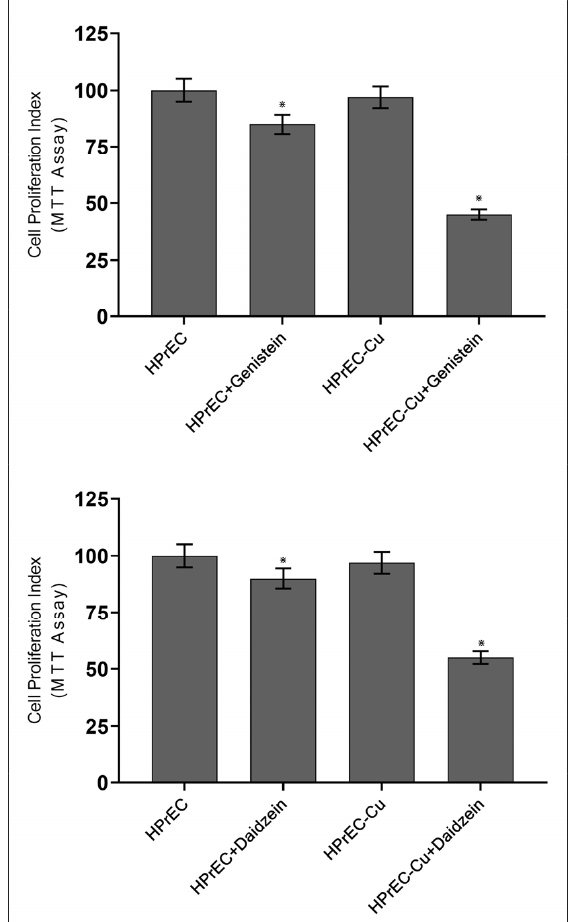
Figure 7. The effect of isoflavones on cell proliferation inhibition in normal prostate epithelial cells (HPrEC) and HPrEC cells cultured in copper-supplemented media (HPrEC-Cu). HPrEC and HPrEC-Cu (normal cells cultured in a medium containing 25 µ M CuCl 2 ) were treated for 96 h with a 50 µ M concentration of genistein/and daidzein. The cell proliferation was then assessed using the MTT assay, as indicated in Section 4. Values reported are mean ± S.E. of three independent experiments. * p value < 0.01 when compared to respective control.